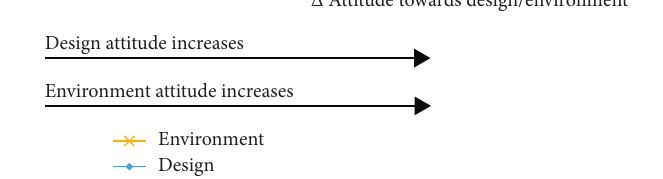
Figure 4: HCM: sensitivity analysis of Δ Probability of choice to install against attitude towards